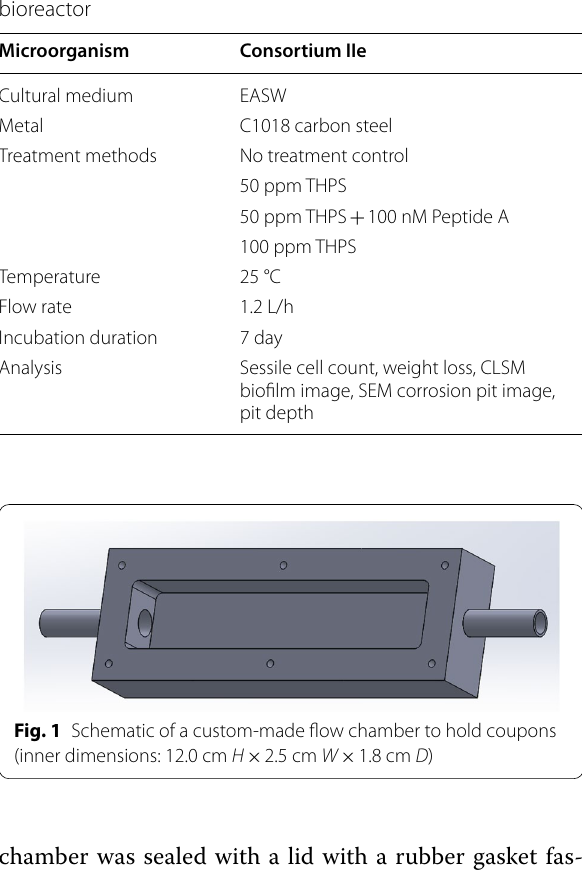
Table 2 Test matrix of biofilm prevention test in a flow loop